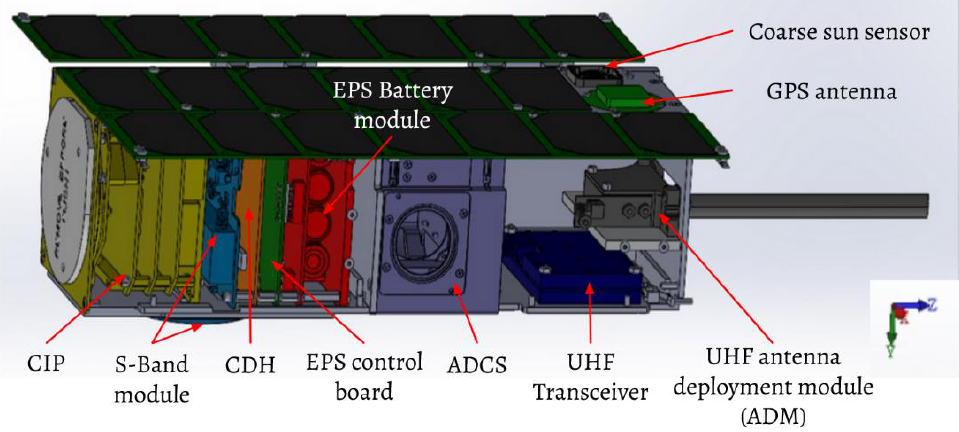
Figure 1. IDEASSat component arrangement.